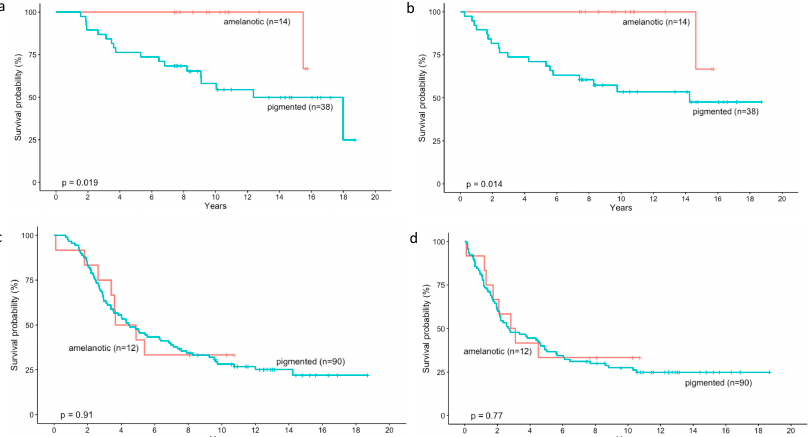
Figure 3. Kaplan–Meier analysis of the prognostic impact of pigmentation degree assessed with indirect ophthalmoscopy in patients with uveal melanoma according to the AJCC classification. Pigmentation affects overall survival ( a ) and disease free survival ( b ) in lower stage (II, both IIA and IIB). Patients with amelanotic tumours live significantly longer, as well as have the lower risk of metastases, than patients with pigmented tumours. In contrast, the degree of tumour pigmentation has no effect on overall survival ( c ) and disease free survival ( d ) in higher disease stages (III, both IIIA and IIIB and IIIC).